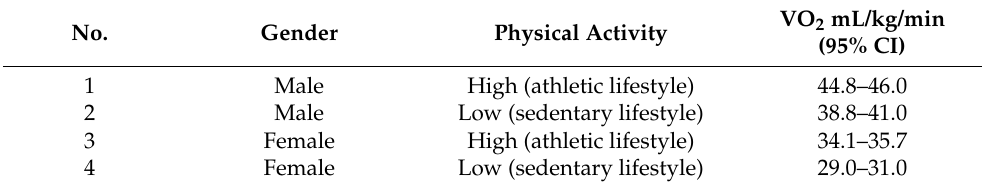
Table 1. The volume of oxygen consumed (VO 2 in mL/kg/min) depending on gender and physical activity, given for one age group (35–44 years), according to literature data [18]. No.